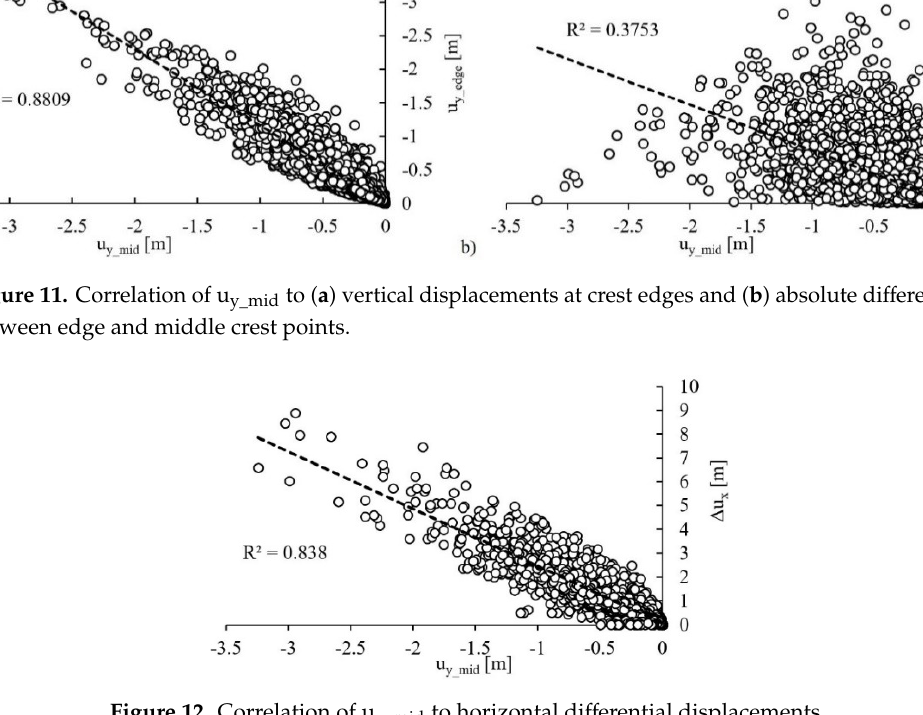
Figure 12. Correlation of u y_mid to horizontal differential displacements.